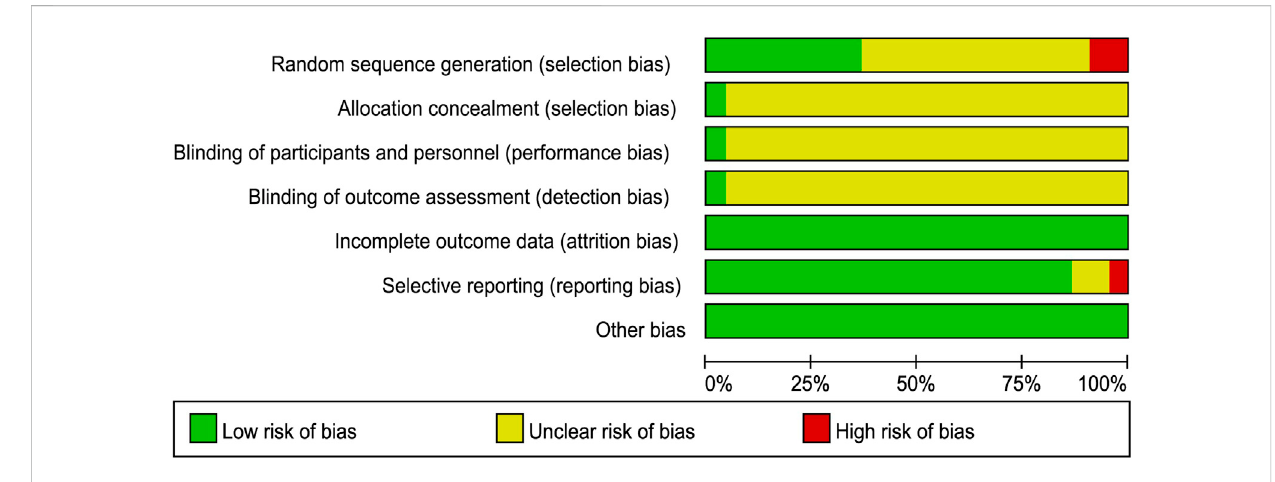
FIGURE 2 Risk of bias